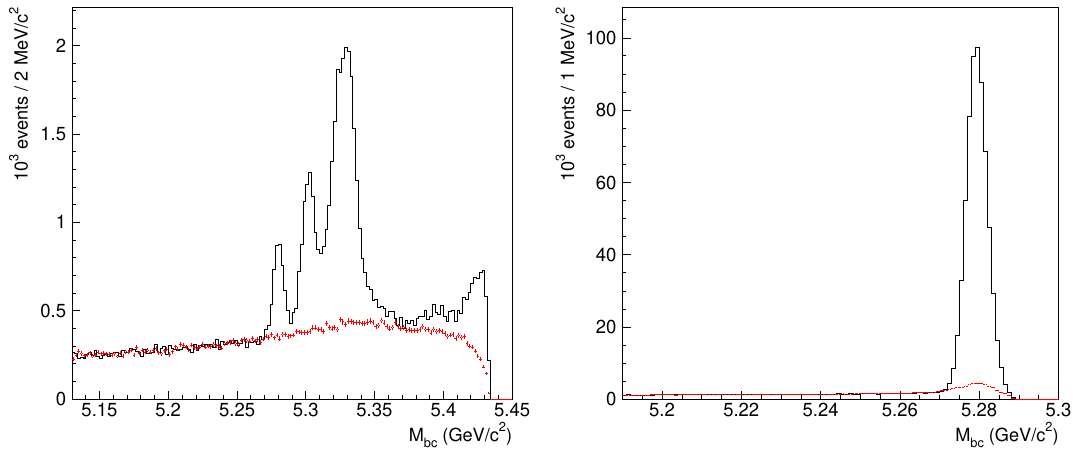
Figure 3 . The M bc distributions in the Υ(5 S ) (left) and Υ(4 S ) (right) data. Black solid histogram shows the ∆ E 0 signal region, while red points with error bars show the normalized ∆ E 0 sidebands.